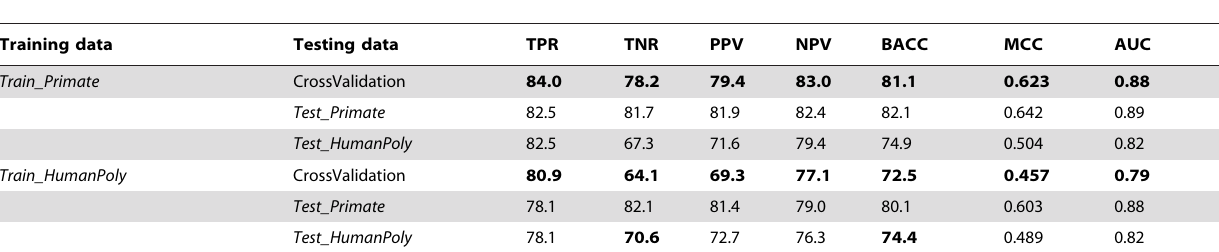
Table 4. Performance of the models trained by human polymorphism and primate